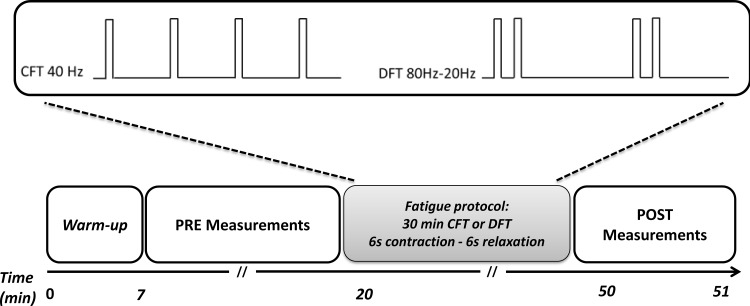
Stimulation pattern and schematic view of the experimental protocol.Upper panel presents the two stimulation patterns. Lower panel presents the experimental protocol. Warm-up consisted of 10 progressive voluntary contractions until the maximal voluntary contraction (MVC). The experimental session then began with different measurements (PRE measurements) including the determination of the optimal stimulation intensity for doublets, tetanic contractions and the session's pattern and tests with two MVCs and two 500 ms tetanic contractions at 20 and 80 Hz. Then, subjects underwent 30 minutes with one stimulation pattern. After the session, POST measurements were performed including two MVCs, doublets, two 500 ms tetanic contractions at 20 and 80 Hz.